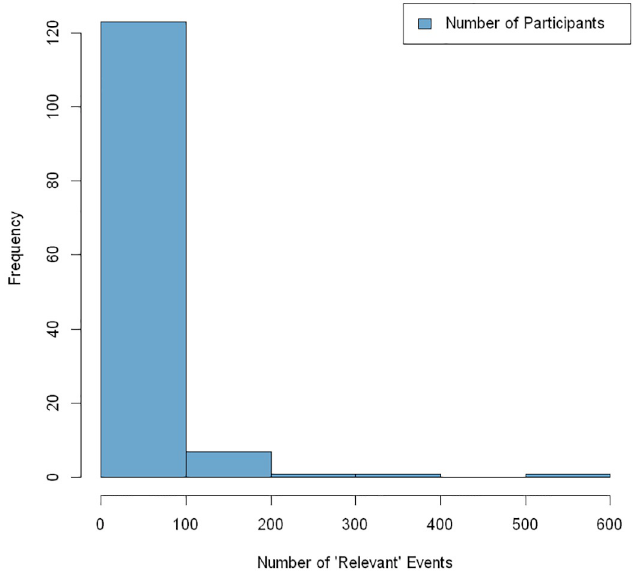
Fig 2. Histogram of user events relevant to the primary function of